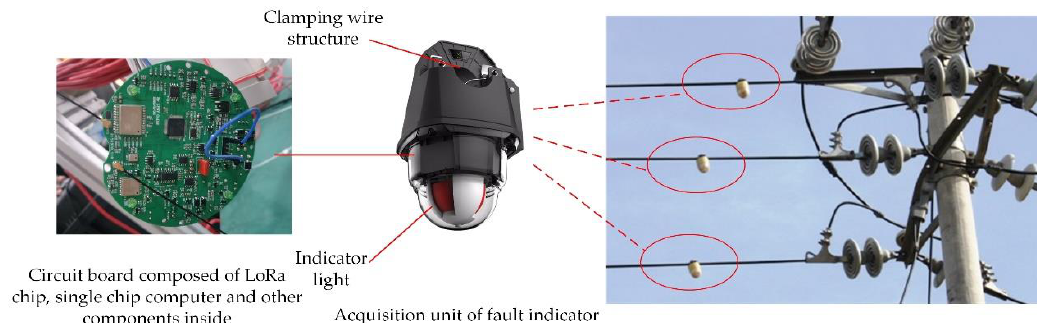
Figure 1. The layout of the acquisition unit of the proposed fault indicator.